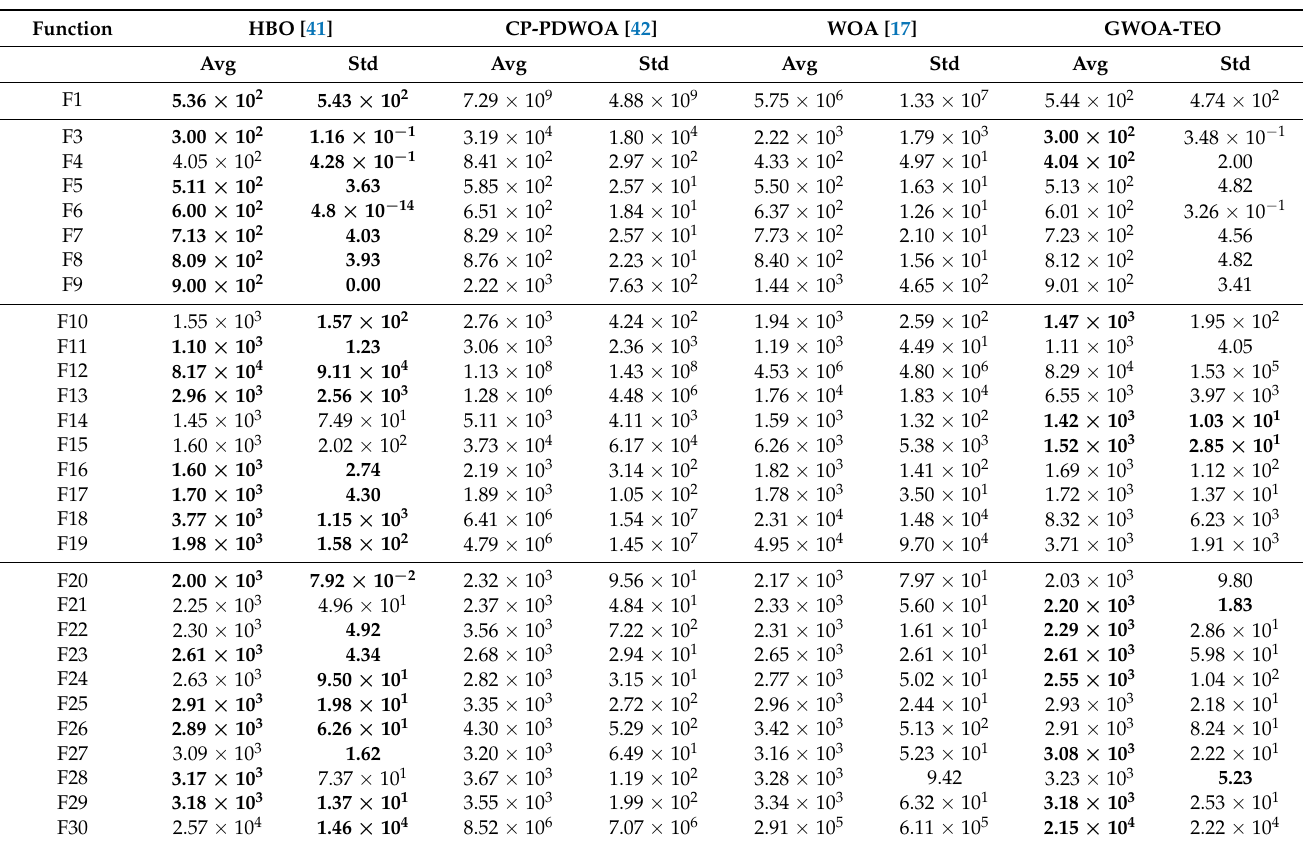
Table 3. Statistical results of the optimization